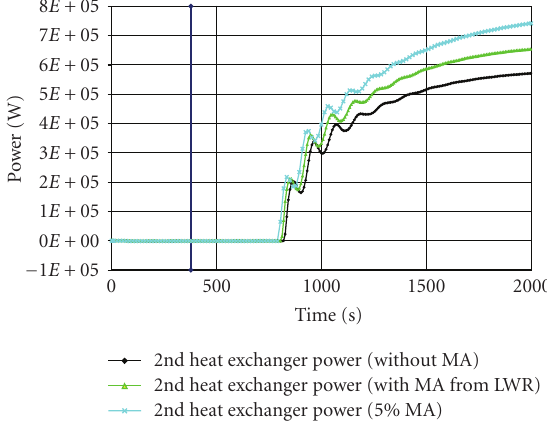
Figure 9: Exchanged power in 2nd DHR